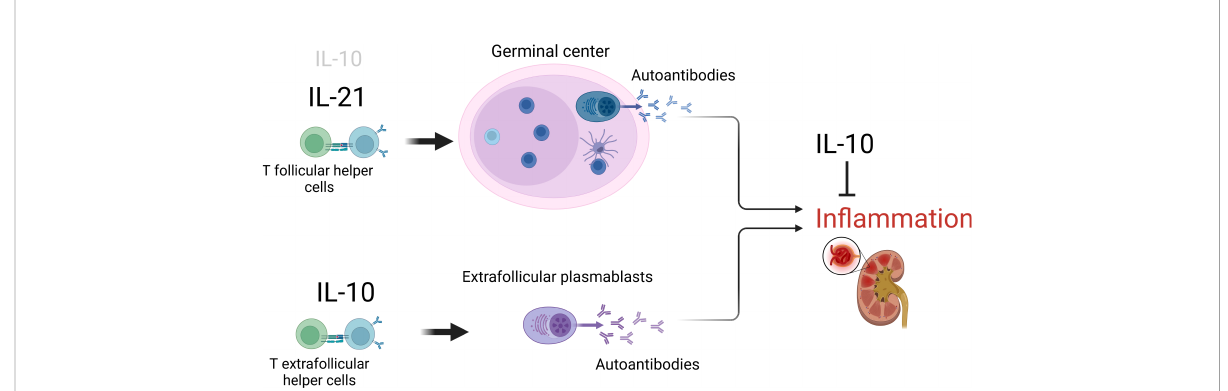
FIGURE 1 The opposing role of IL-10 in SLE. The cytokine drives the continuous formation of pro-in fl ammatory autoantibodies, particularly outside GCs, but can also limit in fl ammatory effector functions. Figure created with